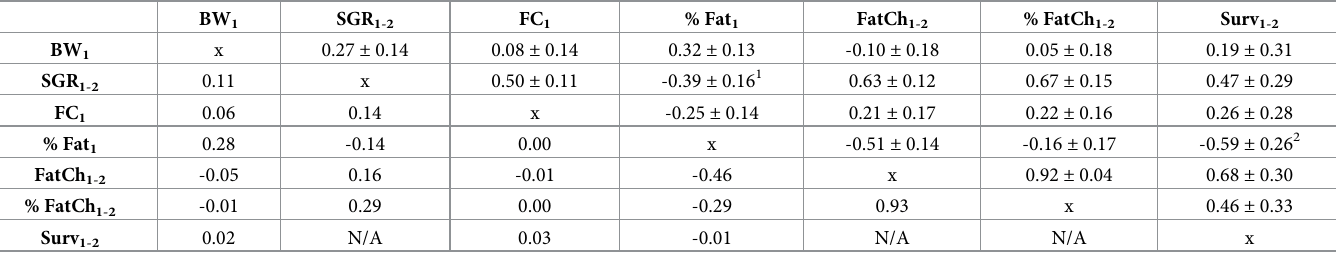
Table 2. Genetic (above the diagonal; ± S.E.) and phenotypic correlations (below the diagonal) of traits before wintering and traits changes during overwintering.